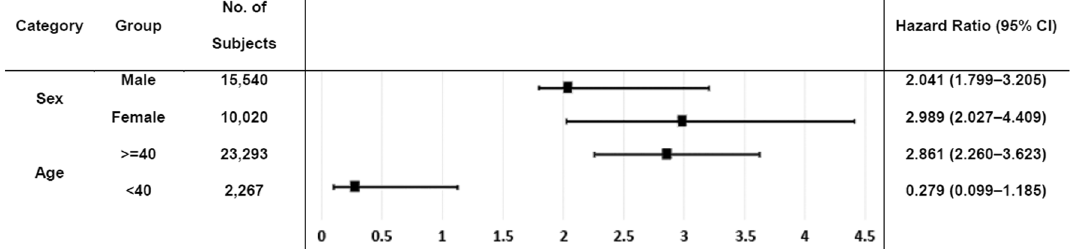
Figure 1. Subgroup analysis of developing open-angle glaucoma according to age and sex based on multivariate Cox